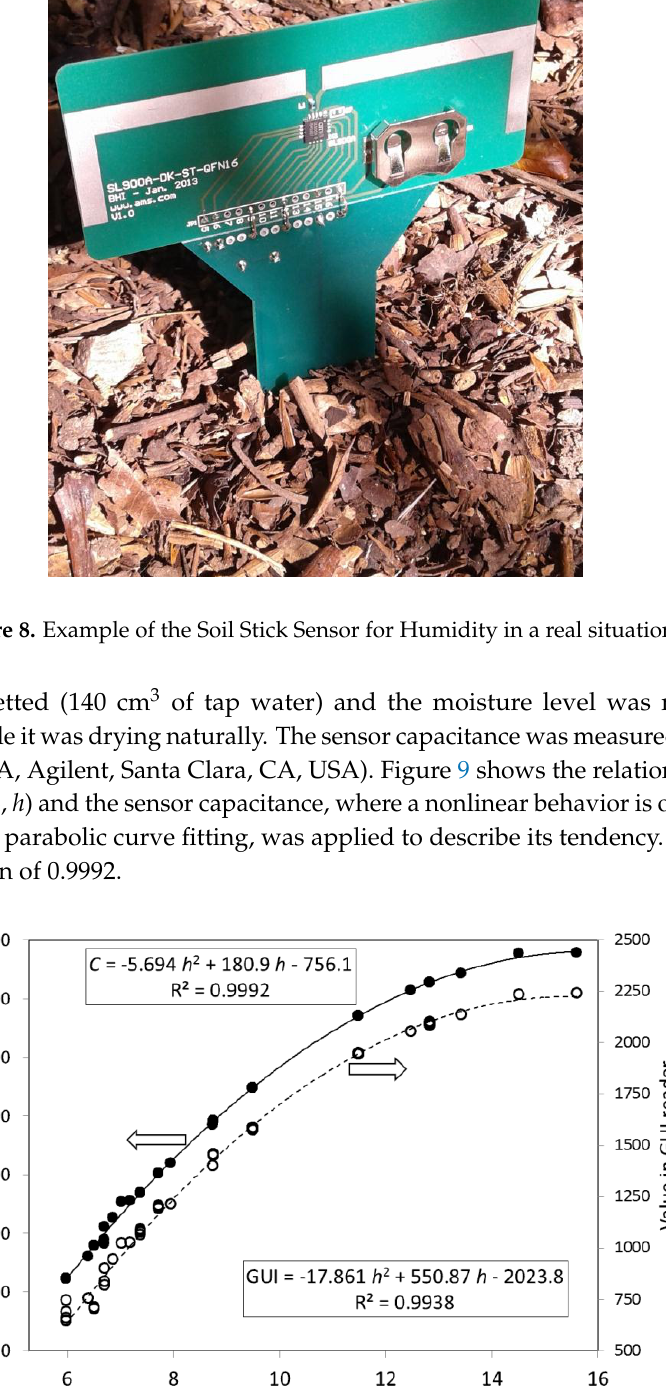
Figure 9. Sensor capacitance (solid dots and line) as a function of soil moisture h (weight ratio). Dashed line and hollow dots are values obtained by GUI of UHF RFID reader. Curves are parabolic approximations.